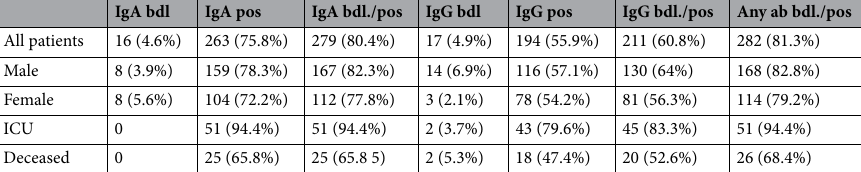
Table 2. Overview of numbers and shares of patients who were tested borderline (bdl.) or positive (pos.) for one or both anti-SARS-CoV-2 antibody (ab) classes within the whole cohort and in distinct